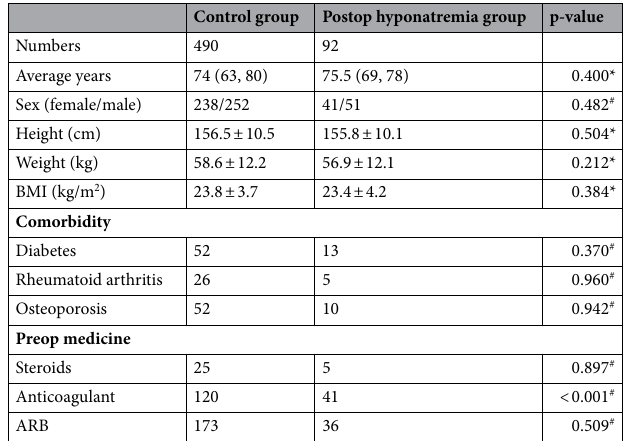
Table 1. Patient characteristics. Continuous variables, except for age, were represented by and average ± 1.0 standard deviation. ARB angiotensin II receptor blocker, BMI body mass index, Preop preoperative, Postop postoperative. *Mann–Whitney U test. # Chi-squared test.